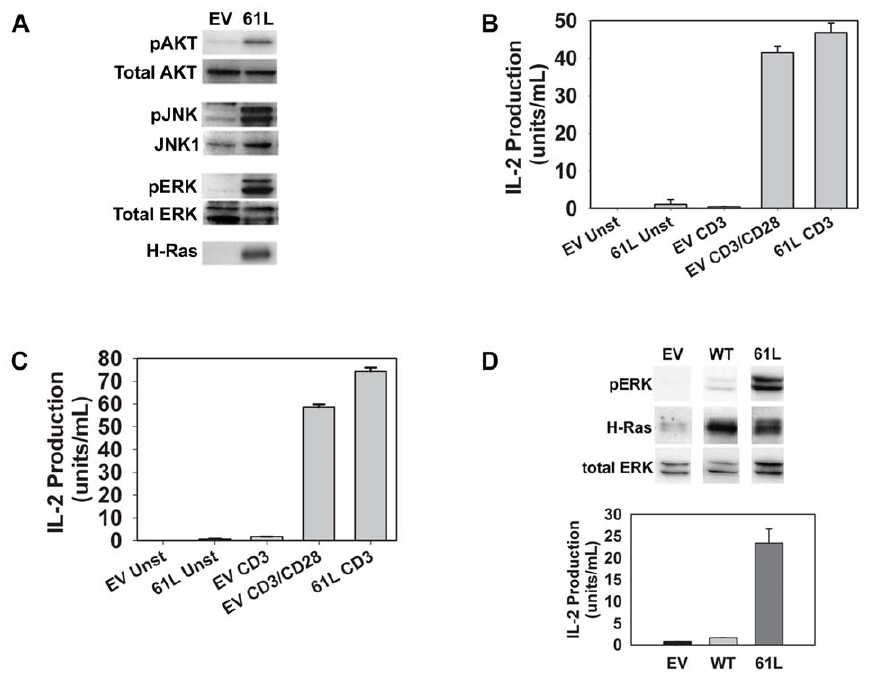
Figure 2. Transduction with active Ras can mimic CD28-mediated costimulation of TCR signaling and IL-2 production. A. CAR Tg Th1 T cells were transduced with adenoviruses encoding constitutively active H-Ras61L (61L) or an empty vector (EV) control as described in materials and methods. Cell lysates of unstimulated, transduced cells were analyzed for phosphorylated AKT, JNK, and ERK or H-Ras (the absence of H-Ras staining in EV transduced cells indicates the absence of H-Ras61L and/or significant amounts of endogenous H-Ras isoform in these cells; total Ras was abundantly detected in both EV and Ras transduced cells (data not shown)). B. CAR Tg Th1 T cells were transduced as in A and stimulated in triplicate overnight with beads coated with anti-CD3 antibody alone or with anti-CD28. Supernatants were collected and analyzed by ELISA for IL-2 production. C. Purified splenic CAR Tg CD4 + T cells were transduced, stimulated and analyzed as in B. D. CAR Tg Th1 T cells were transduced with adenoviruses encoding H-Ras61L (61L), wild type H-Ras (WT) or vector control. Transduced cells were either lysed and analyzed for protein expression (top) or stimulated in triplicate overnight with beads coated with anti-CD3 (bottom), and analyzed for IL-2 production by ELISA. Error bars in B, C, and D represent standard deviation of the mean values from triplicate samples from the same experiment. A significant increase in IL-2 production was seen when active Ras was added to CD3 stimulation in B, C, and D (p , 0.05).